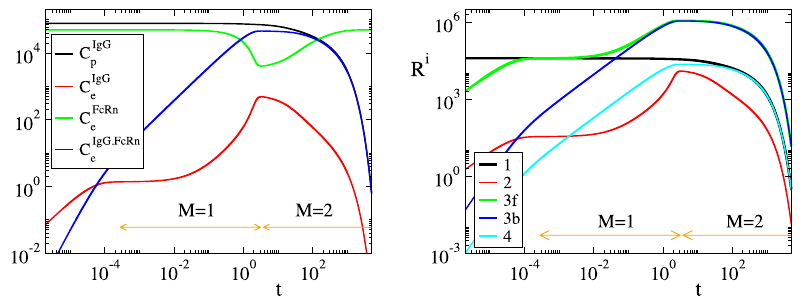
. FcRn IgG IgG FcRn C IgG e , C e (left) and of the rates R p , C e and